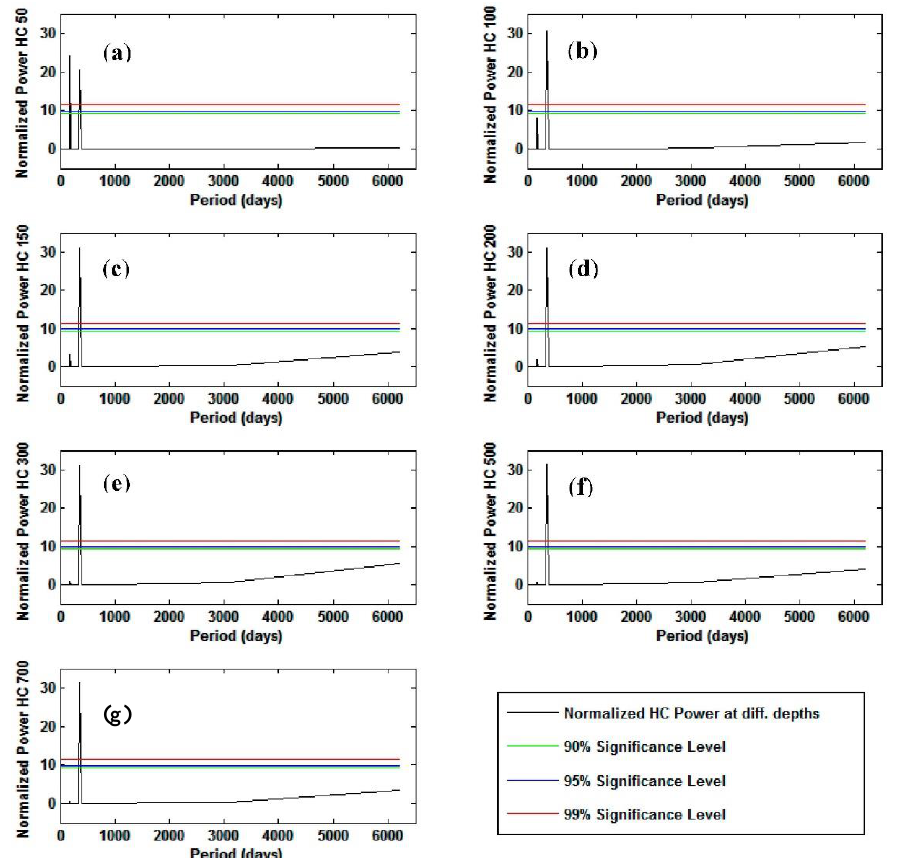
Figure 2. Normalized heat content values (in black) at surface to ( a ) 50m, ( b ) 100m, ( c ) 150m, ( d ) 200m, ( e ) 300m, ( f ) 500m and ( g ) 700m depths. Significance levels at 90%, 95%, and 99% are marked in green, blue, and red, respectively.